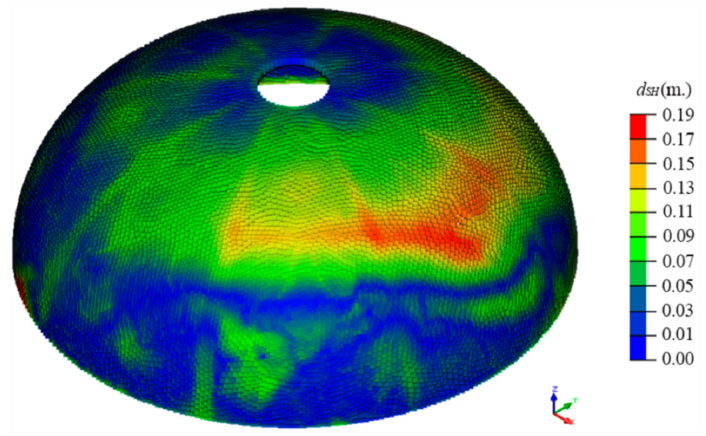
Figure 9. Graphical distribution of the different considered symmetrical Hausdorff distance (d SH